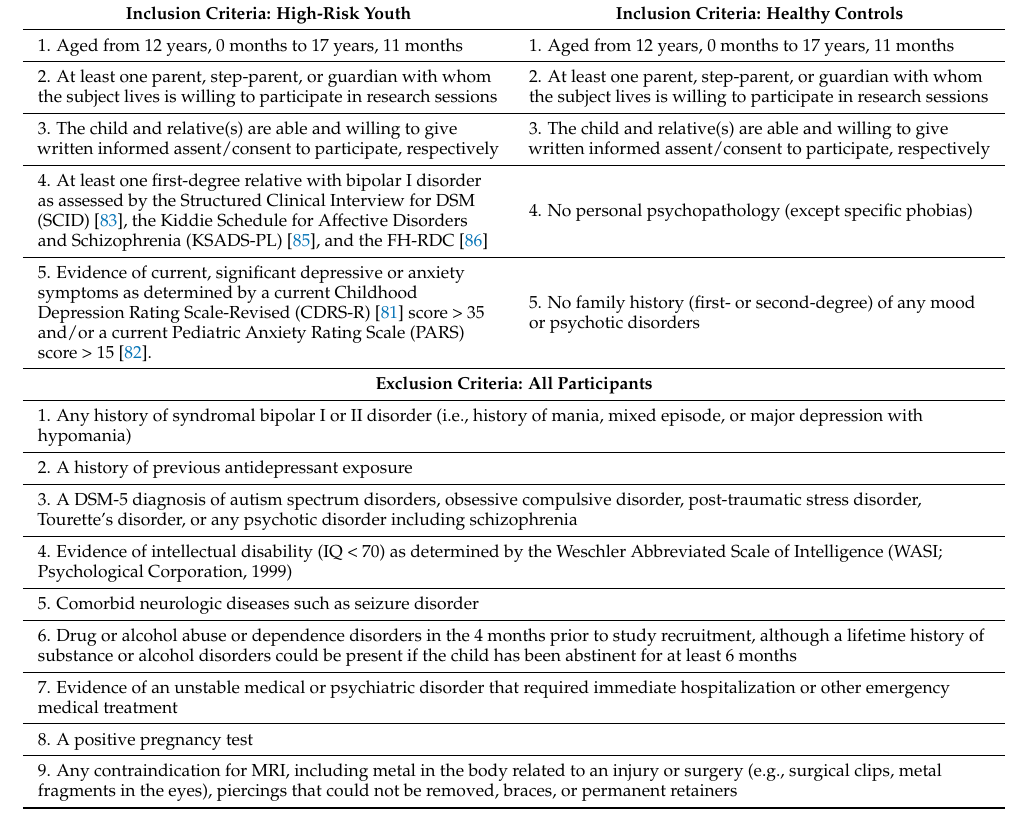
Table 1. Inclusion and exclusion criteria for study